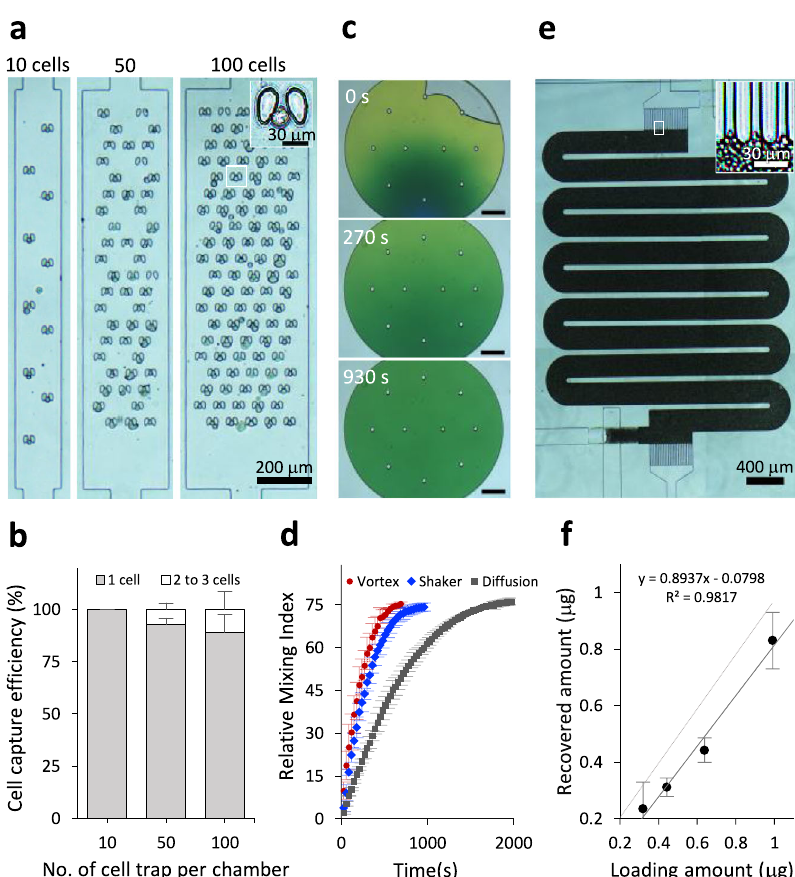
Fig. 2 Performance characterization of the iProChip. a Bright- fi eld images of non-small lung cancer PC-9 cells captured in 10, 50, and 100 cell chambers. Top right: a zoom-in image of a trapped cell. b Characterization of the cell capture ef fi ciency for separate capture chambers. Data are presented as mean values ± SD ( n = 3 independent measurements). c Representative time-lapse images of a reaction vessel fi lled with green dye during mixing-by-shaking characterization. Scale bars: 300 μ m. d Comparison of mixing ef fi ciency in the reaction vessel. Data are presented as mean values ± SD ( n = 3 independent experiments). e A bright- fi eld image of the SPE column packed with C18 beads. Top right: a close-up view near the C18 fi lter. f Desalting recovery ef fi ciency of the on-chip SPE column. Data are presented as mean values± SD ( n = 3 independent experiments). Source data are provided as a Source data fi